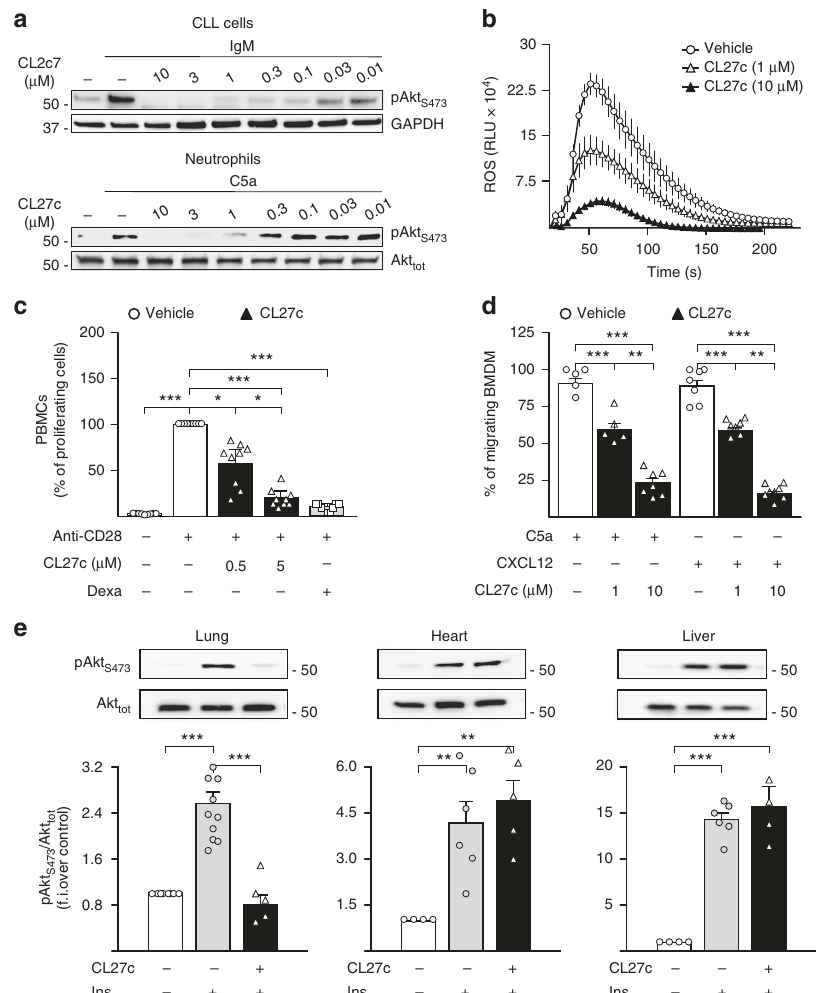
Fig. 1 CL27c inhibits PI3K class I-mediated effects in vitro and in vivo. a Dose response of CL27c (10 nM – 10 µ M) on Akt phosphorylation in CLL cells (upper panel) and primary murine neutrophils (lower panel), stimulated with IgM (20 µ g/ml) and C5a (25 nM), respectively. Western blots are a representative example of at least 5 independent experiments. b Inhibitory effect of CL27c (1 and 10 µ M) on time-course ROS production by fMLP (2.5 μ M)-activated LPS- primed neutrophils ( n = 6 independent experiments for each group). Vehicle (0.1% DMSO diluted in PBS solution) was used as a control group. c Anti- proliferative effect of CL27c (0.5 and 5 µ M) or Dexamethasone (Dexa, 5 mg/kg via i.p. injection) in PBMCs stimulated with anti-CD28 ( n = 9 independent experiments for each group). d CL27c (1 and 10 µ M) inhibits the chemotactic effect of CXCL12 and C5a (100 and 50 nM, respectively) on murine bone marrow-derived monocytes (BMDM) (from left to right, n = 5, 6, 7, 7, 7, 8 independent experiments, respectively). e Inhaled CL27c (2 mg/ml suspension/ 30 min exposure) prevents insulin-dependent (1 UI/kg in PBS i.p.) pAkt activation in the lungs, but neither in the heart nor in liver. Upper panel: representative western blot showing Akt phosphorylation on Ser473 and total Akt. Lower panel: quanti fi cation of fold induction relative to the baseline (f.i.) (from left to right, n = 8, 10, 5, 4, 6, 5, 4, 6, 4 independent experiments, respectively). Results represent mean ± s.e.m. * P < 0.05, ** P < 0.01, *** P < 0.001 determined using one-way ( c , e ) or two-way ( d ) ANOVA followed by Bonferroni post-hoc test